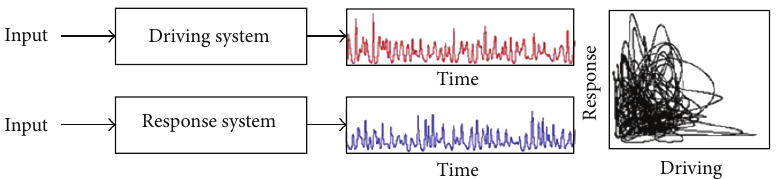
Figure 1: Behaviors of unsynchronized chaotic systems.